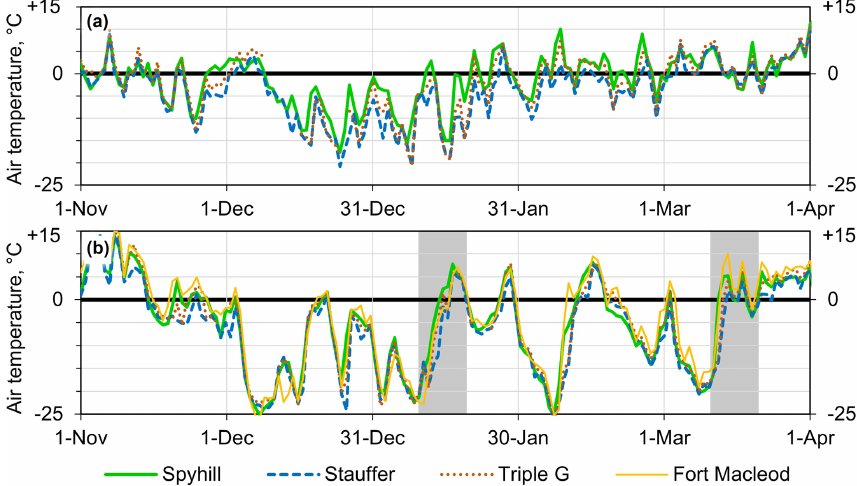
Figure 3. Daily average air temperature at the study sites in the winters of (a) 2015–2016 and (b) 2016–2017. Shaded areas in (b) indicate events shown in Fig. 7. Table 3. Midwinter snow-cover depletion events at the study sites identified on time-lapse photos. Study site Warm spell interval Spyhill Stauffer Triple G Fort